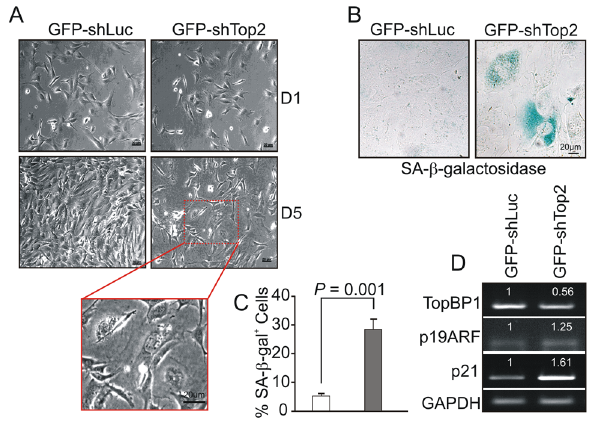
Figure 4. AAD mutation induces premature cellular senes- cence. ( A ) GFP + TopBP1 ki/ + cells were sorted 24 hr after transfection and cultured. Images show the cell density and morphology at D1 and D5. Enlargement shows a representative area of TopBP1 ki/ 2 cells from D5. ( B ) SA- b - galactosidase staining of cells 6 days after shRNA transfection shown in blue. ( C ) Quantification of SA- b - galactosidase positive cells from B. The data represent the mean 6 SD of at least 500 cells from 2 independent experiments. P value: Student’s t -test. ( D ) Semi-quantitative RT-PCR analysis of RNA isolated from D5 cultures from A. The expression level (indicated on top of each sample) was estimated by quantification normalized to the level of GAPDH and then correlated with GFP-shLuc transfected cells. Two independent exper- iments were performed which showed equivalent results.